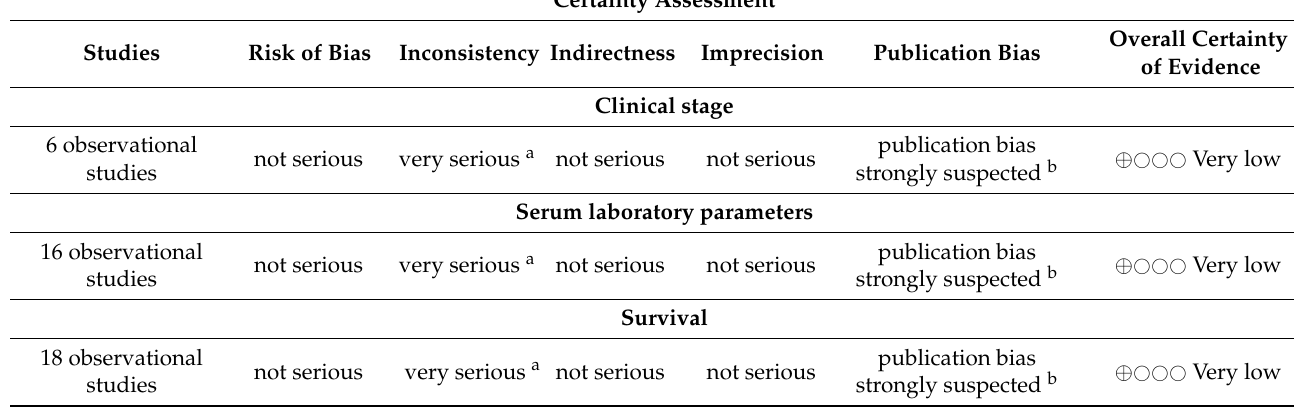
Table 8. Grading of Recommendations, Assessment, Development, and Evaluations-GRADE was used for the certainty assessment of the evidence and the strength of recommendations. This tool is based on risk of bias, inconsistency, indirectness, and imprecision. a . High clinical heterogeneity; b . Risk of publication